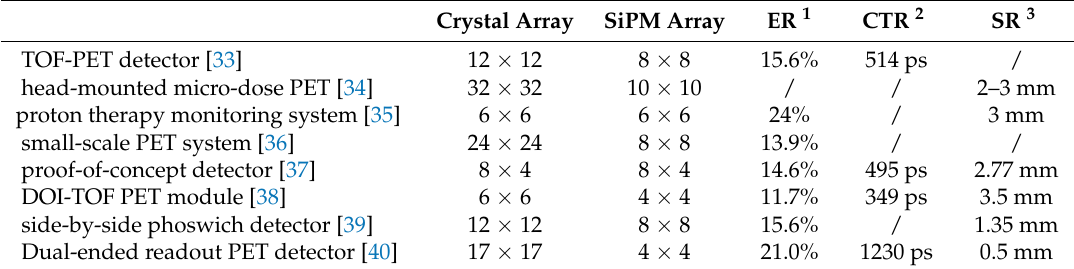
Table 1. The specifications and performances of the detectors developed in the previous studies. Crystal